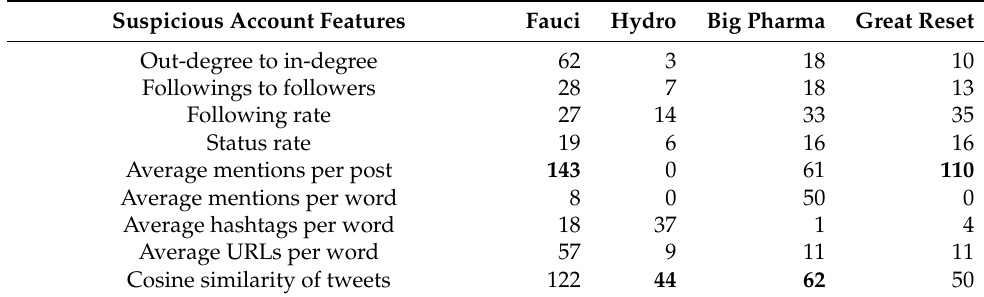
Table 9. The number of users that each feature highlighted as a suspicious per use